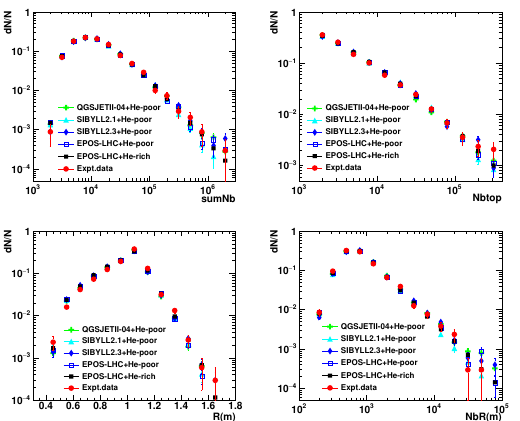
Figure 3. E ffi ciency S Ω of YAC-I array for Proton + Helium un- der the models mentioned above. Table 1. Statistics of air-shower core events in MC simulation